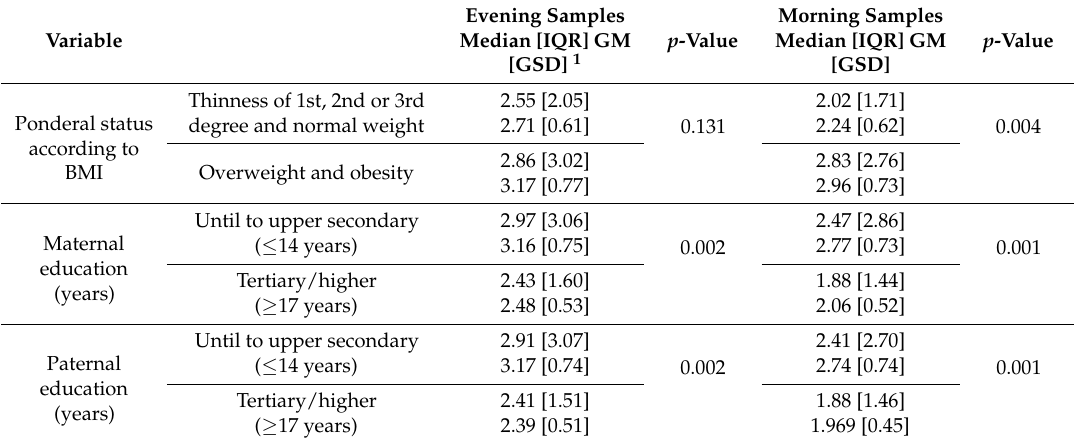
Table 6. Univariate analyses of the u-cotinine levels expressed as µ g g − 1 creatinine (independently for evening and morning urine samples) for ponderal status according to Body Mass Index (BMI), mother's and father’s educational